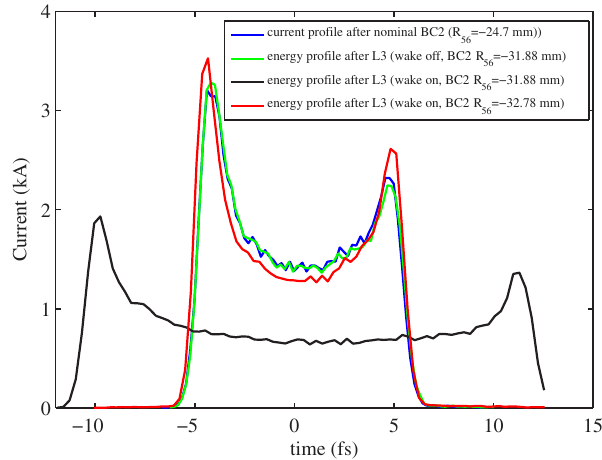
FIG. 2. LITRACK simulations showing current profile of the LCLS 20-pC, ultrashort bunch after the nominal BC2 setting (with R 56 ¼ (cid:2) 24 : 7 mm ) (blue curve), energy profile after in- (cid:1) R j ¼ 7 : 18 mm ) and traversing L3 creasing BC2 strength (by j 56 at the (cid:2) 90 (cid:10) zero-crossing phase (green curve for L3 wake off and black curve for L3 wake on), and energy profile after (cid:1) R þ (cid:2) (cid:1) R j ¼ 8 : 08 mm ) and increasing BC2 strength (by j 56 56 FIG. 3. LITRACK simulations of rms bunch length for the LCLS traversing L3 at the (cid:2) 90 (cid:10) zero-crossing phase (L3 wake on, red curve). The energy coordinate is divided by h 3 according 20-pC bunch after BC2 (5% area cut in current or energy to Eq. (4) and is converted to time by speed of light. L2 phase distributions). The nominal BC2 R 56 ¼ (cid:2) 24 : 7 mm , and R 56 ¼ (cid:2) 32 : 78 mm for the bunch length measurement. (cid:7)